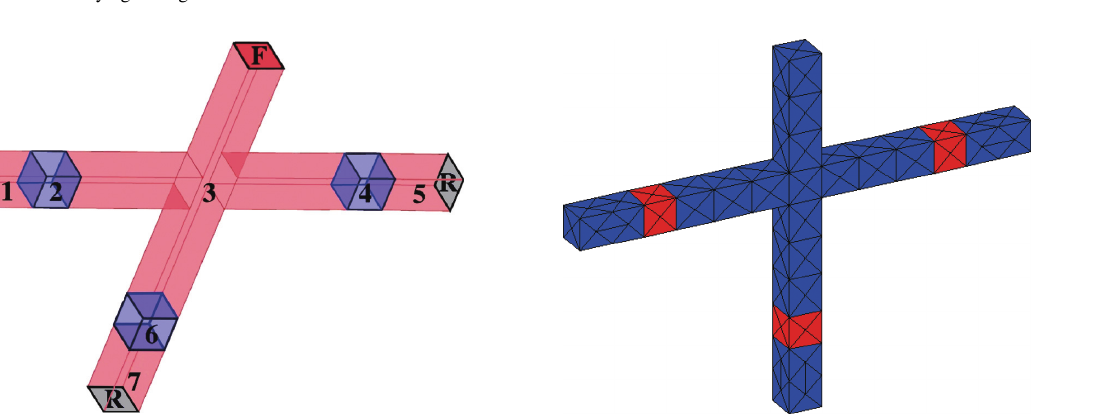
Fig. 3. The test structure used in this paper consisting of seven substruc- tures. Boundary conditions are indicated by R (Rigid or Fixed) or F (unit surface force condition in all the spatial directions).